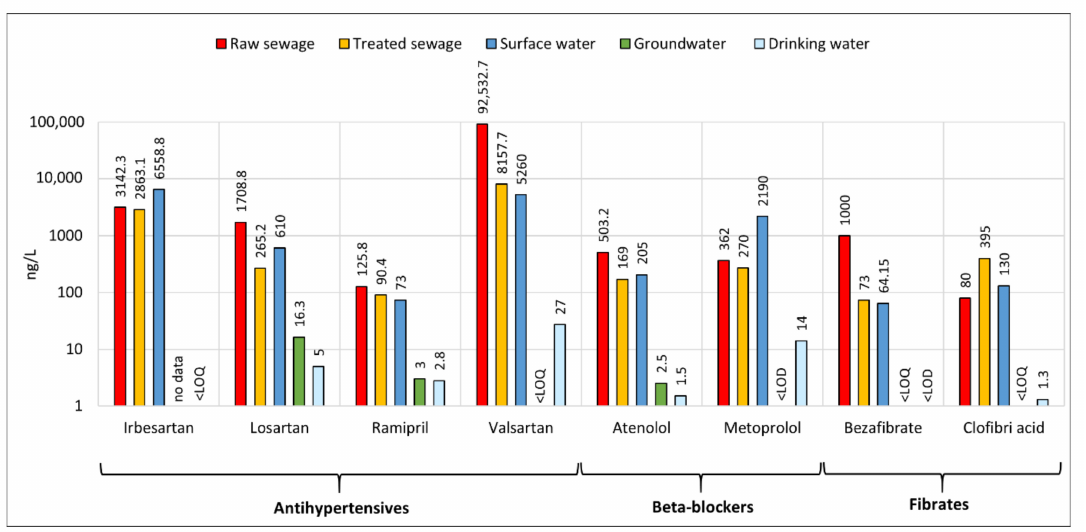
Figure 6. Variations in maximum concentrations of selected antihypertensives, beta-blockers and fibrates in different water sample types.